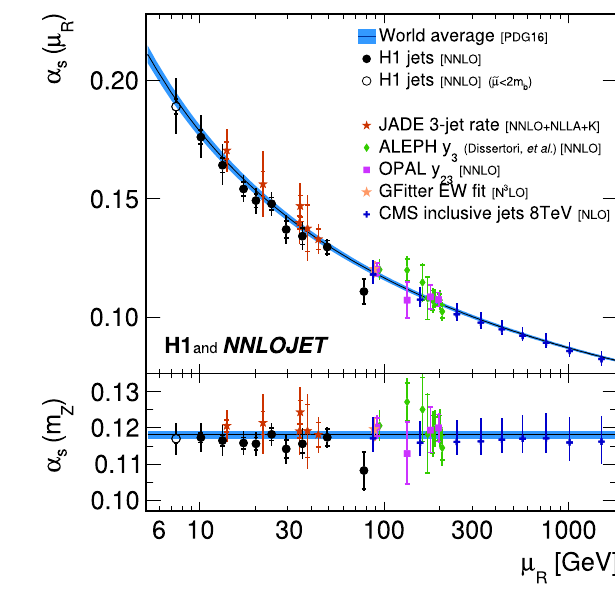
Fig. 13 Results on α s ( m Z ) and α s (μ R ) for fits to data points arranged in groups of similar μ R . The circles show results from inclusive jet and dijet data taken together (‘H1 jets’), the open diamonds results from inclusive jet cross sections alone and the open boxes results from dijet cross sections alone. For these fits, the data sets are not constrained by the requirement ˜ μ > 2 m b . The fitted values of α s ( m Z ) (lower panel) are translated to α s (μ R ) (upper panel), using the solution of the QCD renormalisation group equation. The data points from fits to inclusive jets (dijets) are displaced to the left (right) for better visibility. In the upper panel a displacement is also applied along the vertical direction, to account for the running of α s (μ R ) . The inner error bars denote the experimental uncertainties alone, and the outer error bars indicate the total uncertainties